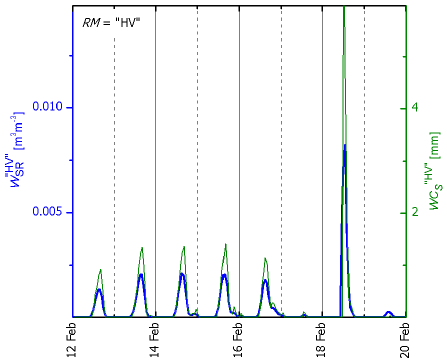
Figure 6. Same snow liquid water content retrievals (cid:1849) (cid:2903),(cid:2902)"(cid:2892)(cid:2906)" during the “early-spring period” as in Figure 5a (blue, left axes). Corresponding snow liquid water column (cid:1849)(cid:1829) (cid:2903),(cid:2902)(cid:3019)(cid:3014) = (cid:1849) (cid:2903),(cid:2902)(cid:3019)(cid:3014) ⋅ ℎ (cid:2903) (green, right axes) considering snow height ℎ (cid:2903) , as shown in Figure 2a.